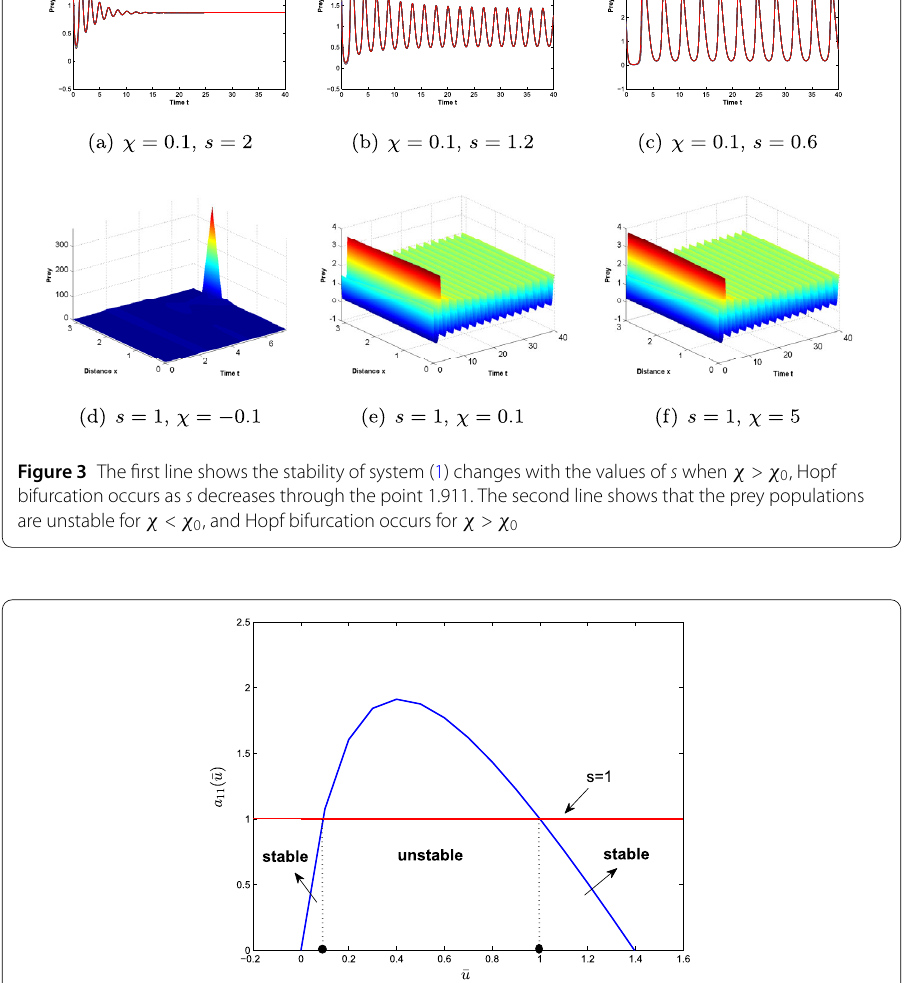
Figure 4 The distribution of stable regions for s = 1, there is no Hopf bifurcation for ¯ u ∈ (0,0.0902) ∪ (1,+ ∞ ), and the Hopf bifurcation may occur for ¯ u ∈